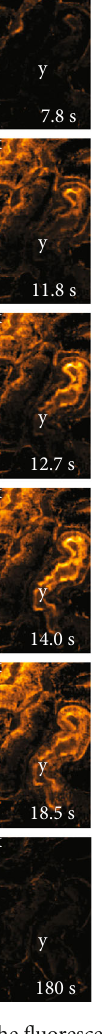
Figure 2: Time series showing the fl uorescence signal in the kidney cortex of a bolus injection of ASP+. To visualize the passage of the injected bolus through the renal structures, the image recorded at t = 0 has been subtracted from the images recorded at each time point. 7.8s: the bolus of ASP+ is visible in the glomerular capillaries (g), Bowman ’ s space (b), and in some peritubular capillaries (c) as well as in the very basal part of cells in the proximal tubule (x) adjacent to capillaries with visible ASP+. Proximal tubules in areas of the cortex in which the bolus has not yet reached the capillaries or tubular lumen (y) do not show ASP + signal at this time. Scalebars: 50 μ m .11.8 s: the proximal tubule labelled y begins to show basal ASP+ signal, and a strong ASP+ signal appears also in the brushborder of this proximal tubule. In the proximal tubule labelled x, the basal ASP+ signal now appears intracellular and di ff use. 12.7s and 14.0s: the strong ASP+ signal in the brushborder of tubule y spreads along the tubule and di ff use intracellular signal develops. 18.5s: the strong ASP+ signal in the brush border of tubule y gradually diminishes but the di ff use intracellular signal remains. 180s: the signal from the bolus of ASP+ is no longer